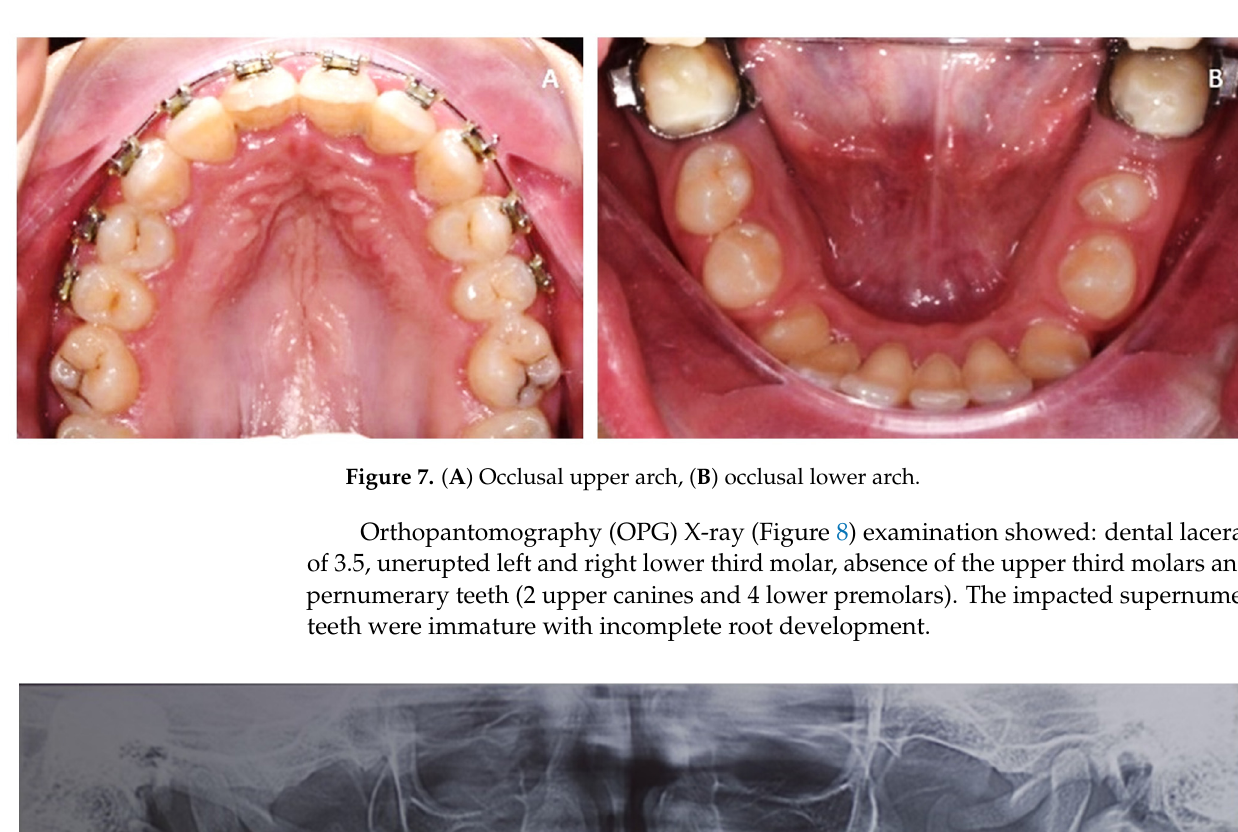
Figure 7. ( A ) Occlusal upper arch, ( B ) occlusal lower arch.